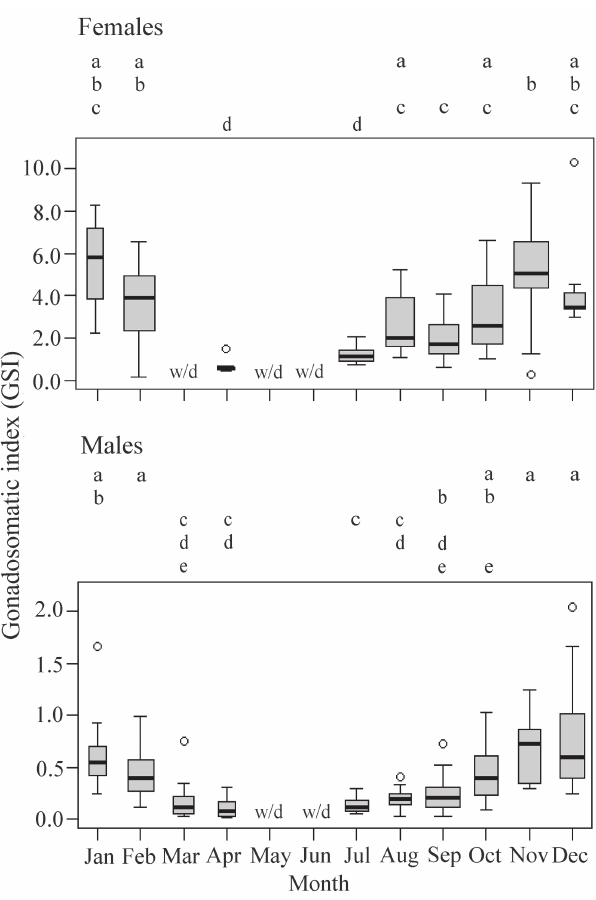
Fig. 3. Monthly evolution of the proportion of gonad stages (excluding immature fish) for females ( n = 147) and males ( n = 188) Pinguipes brasilianus . The X symbol over some bars indicates those cases in which ten or less gonads were classified.